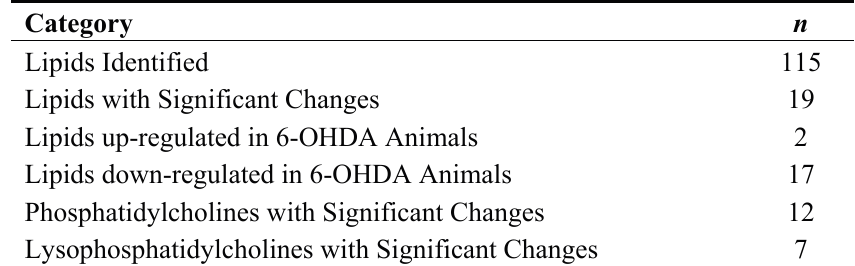
Table 1. Summary table of lipidomic findings. The class of lipids was determined using the LIPID MAPS MS Prediction